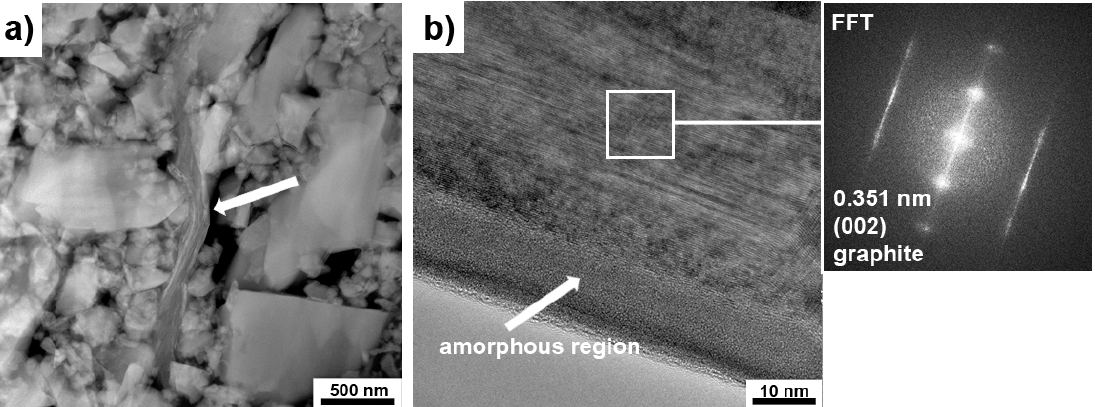
Figure 7. Transmission electron microscopy (TEM) analysis of SiC–C–B–Ti 3 C 2 powder after annealing at 1600 °C: ( a ) Dis- ordered carbon structures, ( b ) high-resolution transmission electron microscopy (HRTEM) image and fast Fourier trans- form (FFT) pattern of DCS.